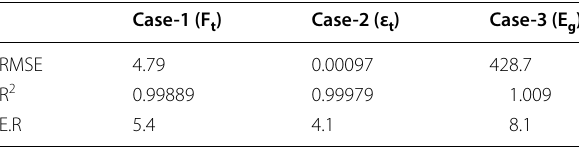
Table 3 Results of the Statistical